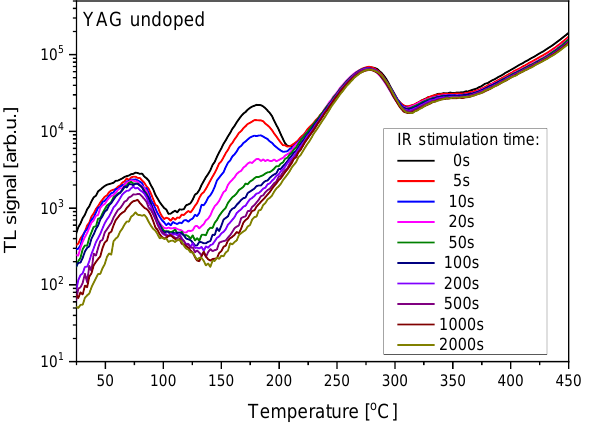
Figure 8. Influence of the variable time of IR illumination on TL glow-curves of undoped YAG crys-